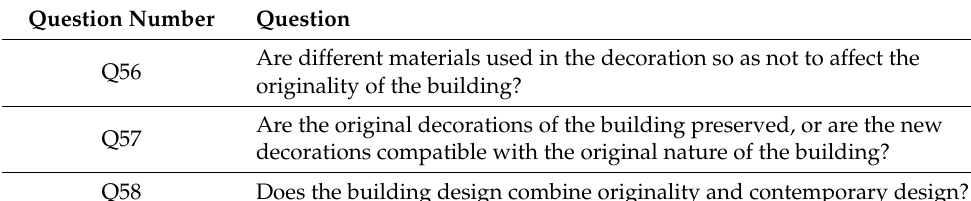
Table 11. Interior design questions (aesthetic and decorative design).